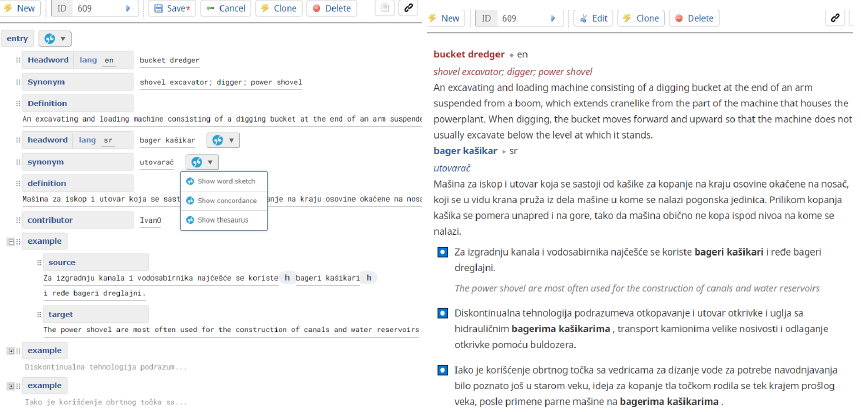
Figure 8. The Lexonomy data entry editing and preview for term